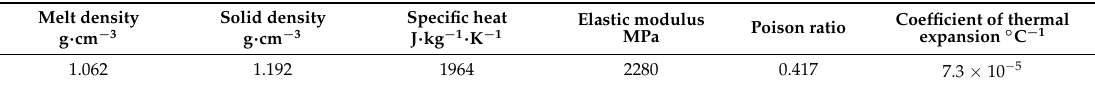
Table 4. Basic properties of PC X-1.